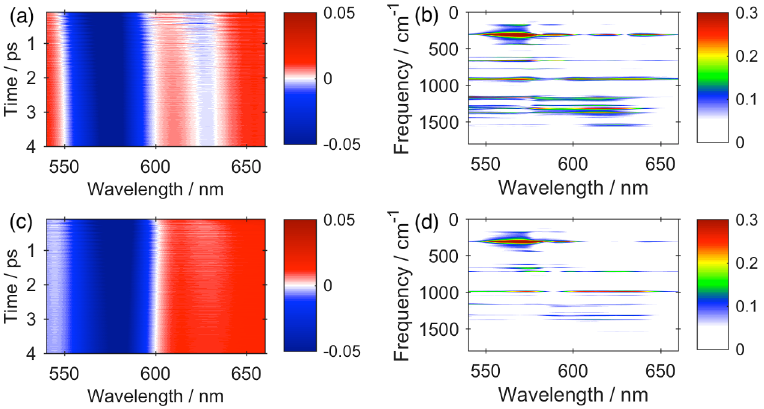
Fig. 1. Transient absorption map of BPEN in (a) THF and (b) DEA. Amplitude of Fourier transformed spectra of the residuals obtained by subtracting slow varying dynamics of TA signals of BPEN in (c) THF and (d) DEA.